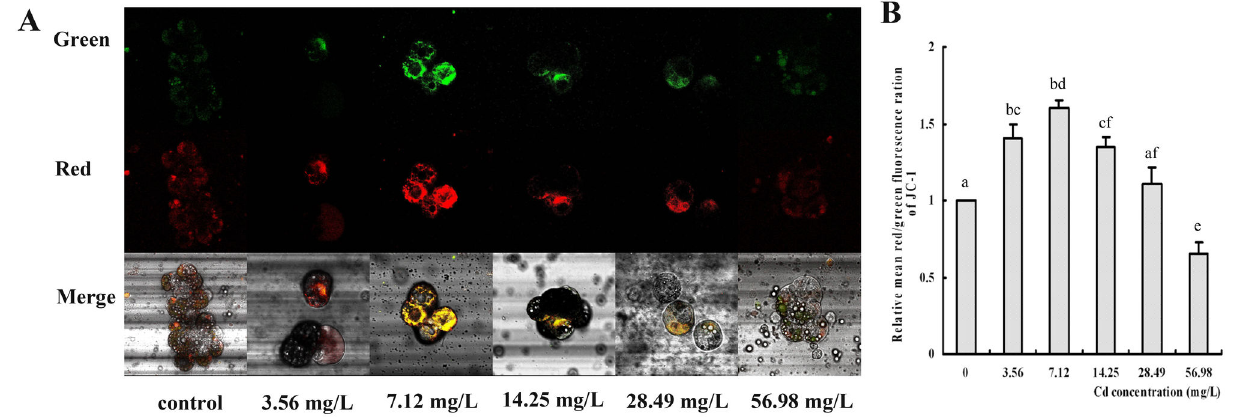
Figure 6. Mitochondrial membrane potential changes in S. henanense hepatopancreas cells labeled with JC-1 ( n = 4). ( A ) Typical fluorescence micrographs captured by laser scanning confocal microscopy. Upper and middle panels show monomer (green) and aggregate (red) fluorescence, respectively. The other panels show the merged pictures of two images. ( B ) Histogram of the relative values of the mean red/green fluorescence ratios. The mean expression in each treated group is shown as fold increase compared with the mean expression in the control, which has been ascribed an arbitrary value of 1. Values are expressed as the mean ± SD. Significance was determined by one-way ANOVA (The different small letters were used to indicate the significant difference ( p < 0.05) between groups, compared with control). doi: